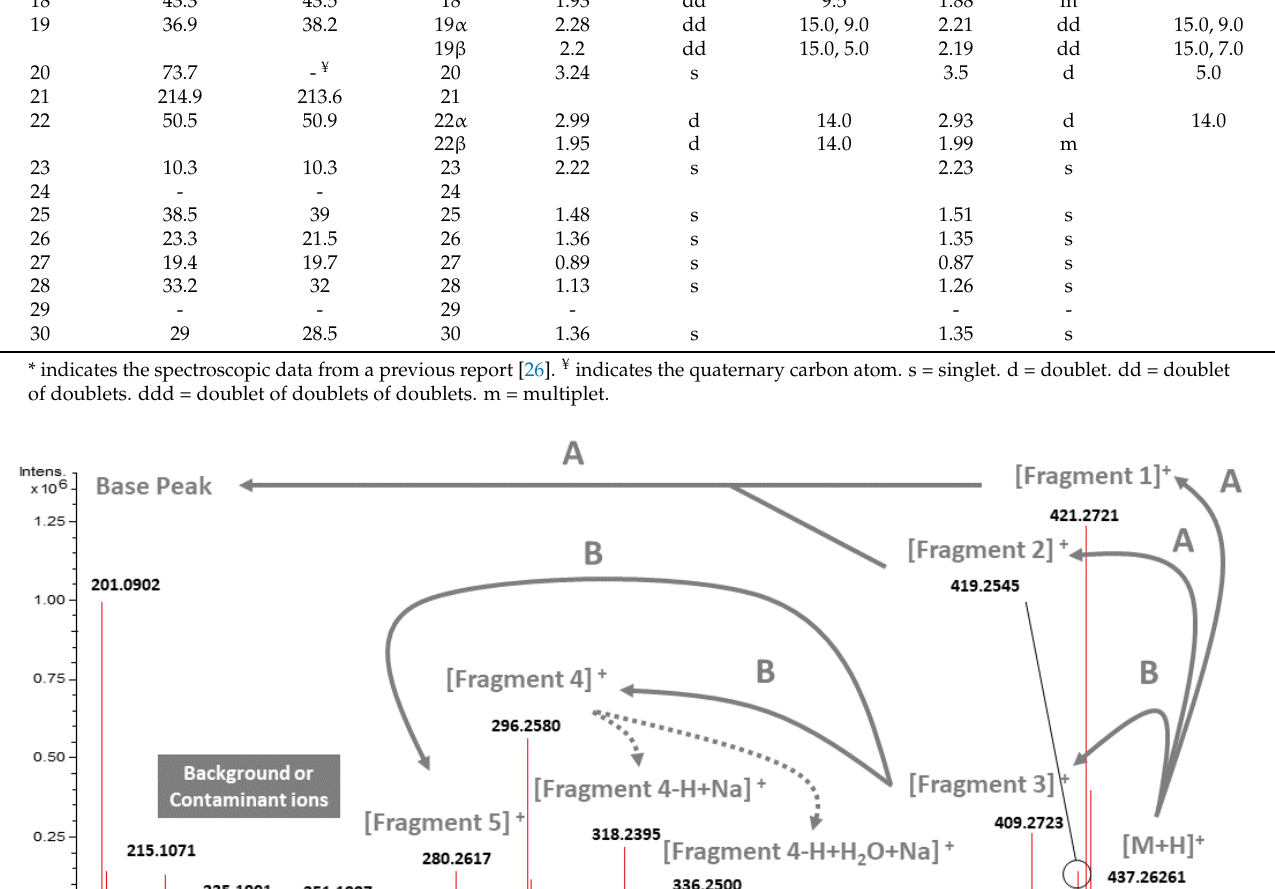
Figure 2. Proposed mass fragmentation scheme of 20-HM from a previous study and the PubChem database of 20-HM derivatives ( A ); proposed mass fragments by adopting CFM-ID program version 3.0 prediction ( B ). The predicted frag- ments of 20-HM from the CFM-ID program are shown in the boxes. (see Supplementary Material, Figure S4).